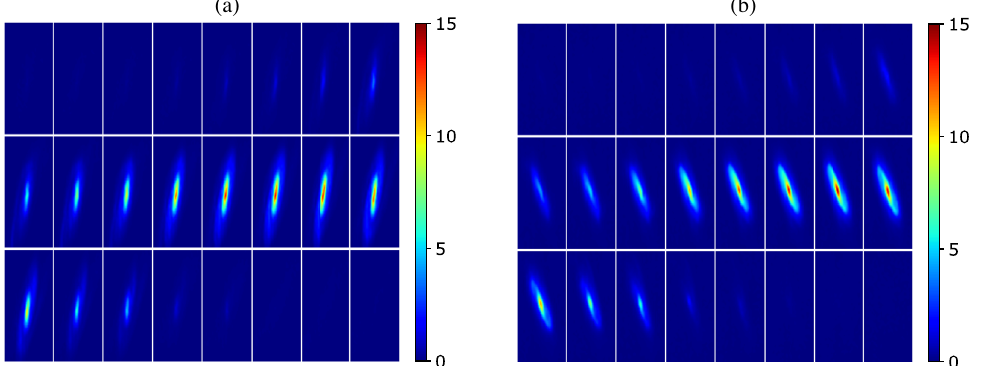
FIG. 15. Measured 24 slices of the phase space distributions over a single bunch of the 1.4-MW neutron production H − beam using laser comb. The time delay between emittance slices is 20 ps. (a) Horizontal phase space. (b) Vertical phase space.